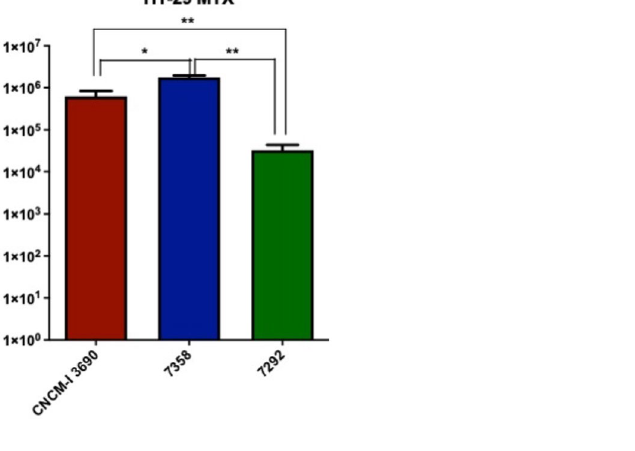
Figure 4. Percentage of adhesion (%) to HT-29-MTX cells of the EPS-overproducer (7292) and underproducer (7358) variants in comparation with the wild-type L. rhamnosus CNCM I-3690. Significance: * p < 0.05 (n = 3 × 3).